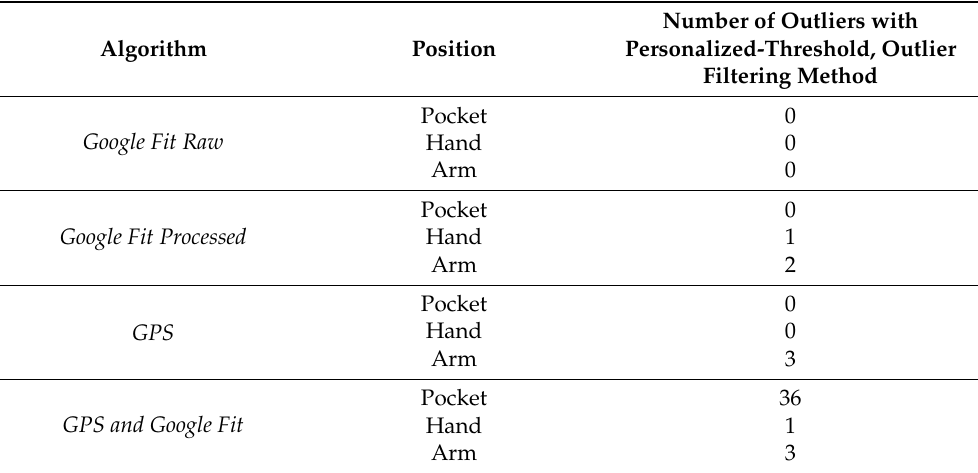
Table 2. Number of missing values and number of outliers for each combination of algorithm– smartphone position for the smartphone-measured, standardized six-minute walk test. Number of Outliers Algorithm Position